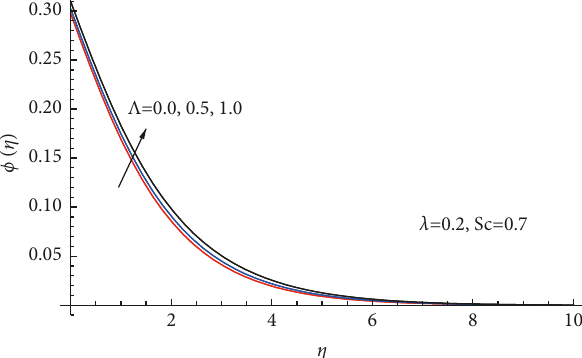
Figure 9: Influence of Λ on θ ( η ) .